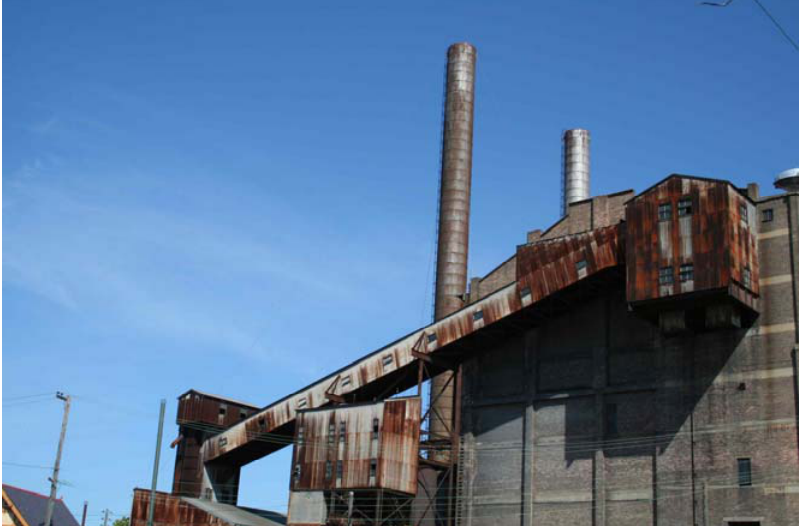
Figure 3. White Bay Power Station